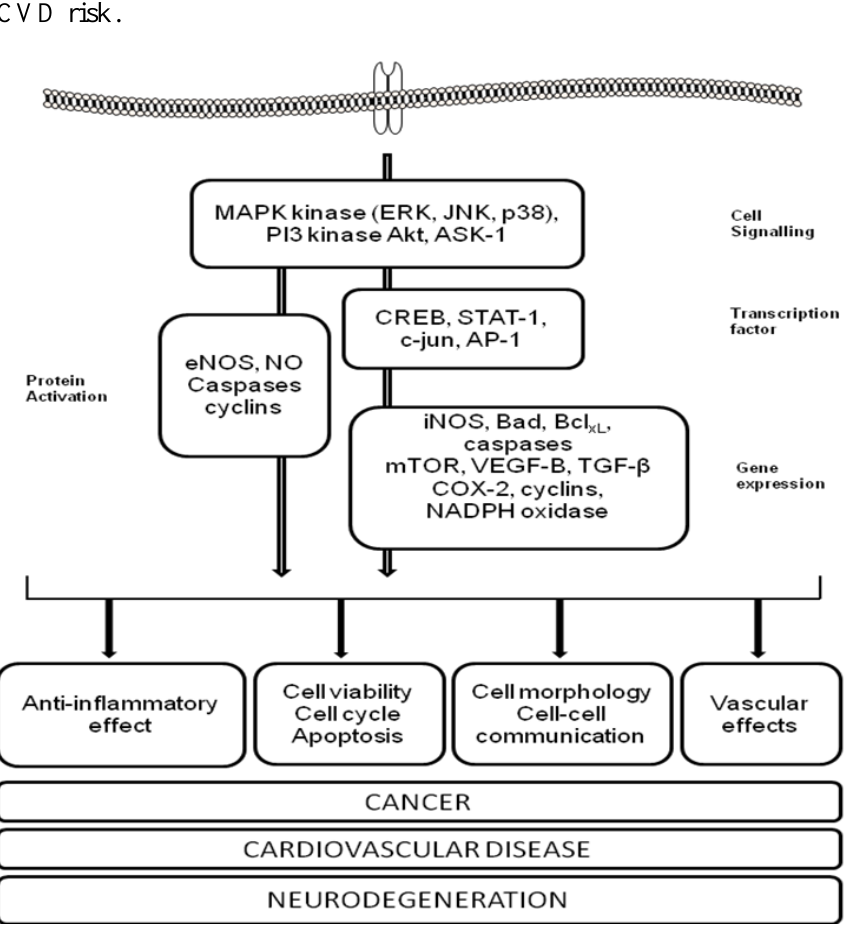
Figure 1. The interaction of polyphenols with cellular signaling pathways involved in chronic disease. Flavonoid-induced activation and/or inhibition of MAP kinase and PI3 kinase signaling leads to the activation of transcription factors which drive gene expression. For example, activation of ERK/Akt and the downstream transcription factor CREB by flavonoids may promote changes in neuronal viability and synaptic plasticity, which ultimately influence neurodegenerative processes. Polyphenol-induced inhibition of the JNK, ASK1 and p38 pathways leads to inhibition of both apoptosis in neurons and a reduction of neuroinflammatory reactions in microglia (reduced iNOS expression and NO• release). Alternatively, their interaction with signaling may lead to direct activation of proteins such as eNOS, which controls nitric oxide release in the vasculature and thus influences CVD